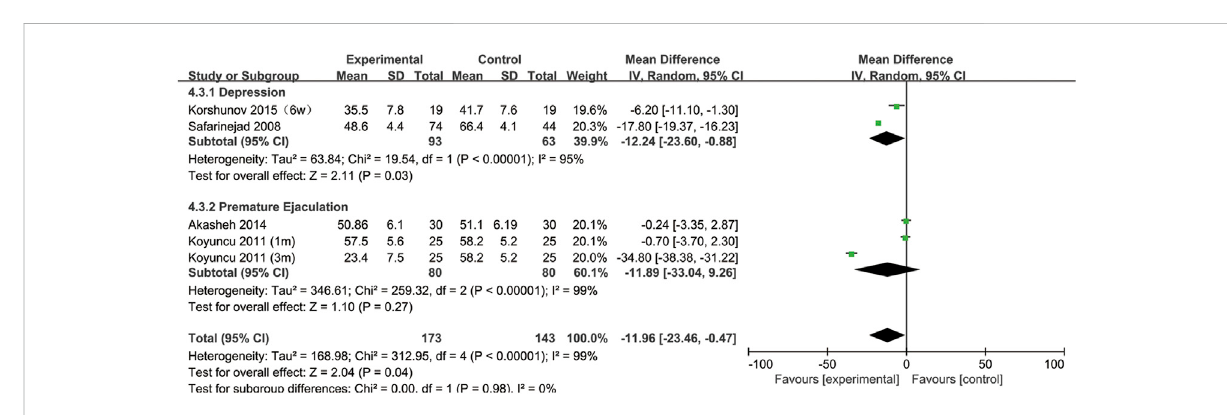
Subgroup of the association between sperm motility and different basic disease.